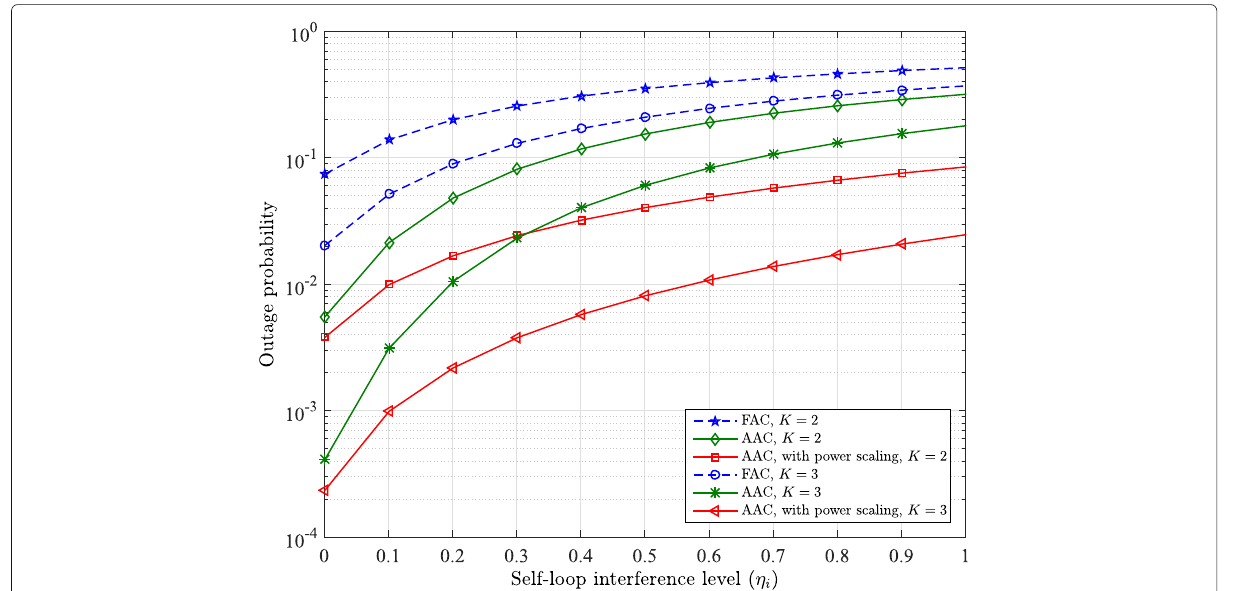
Fig. 8 Outage performance versus η i for different values of K : FAC, AAC, and AAC with power scaling